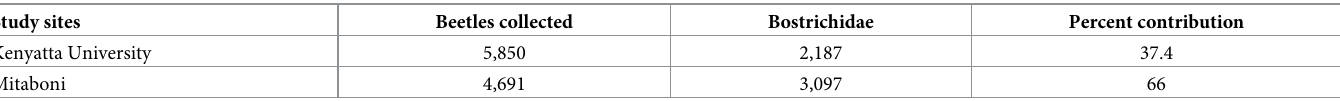
Table 1. Percent contribution of the family Bostrichidae recovered from Acacia xanthophloea at Kenyatta University and Mitaboni. Study sites Beetles collected